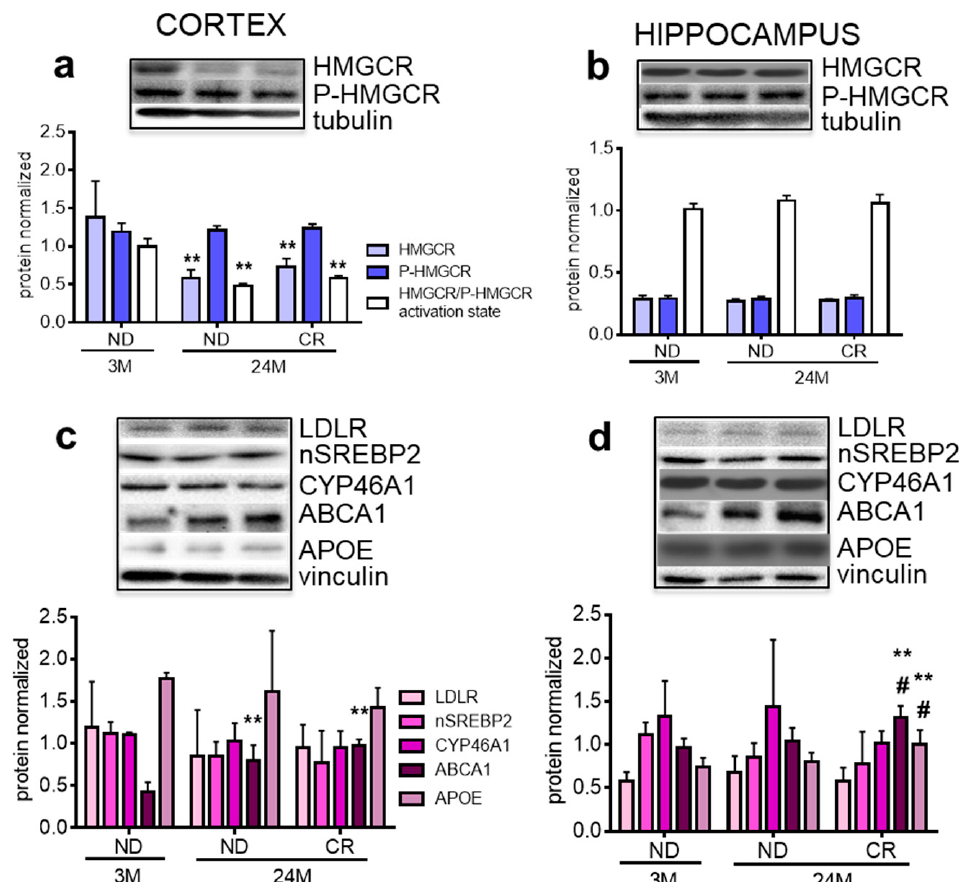
Figure 2. Impact of age and CR on proteins handling cholesterol metabolism in rat cortex and hippocampus. Panels ( a , b ) show representative Western blots and densitometric analyses of HMGCR (total and phosphorylated protein) in the cortex and hippocampus, respectively. Panel c and d show representative Western blots and densitometric analysis of other proteins involved in cholesterol homeostasis in the cortex and hippocampus, respectively. 3M (3-month-old rats); 24M (24-month-old rats); ND (normal diet); CR (caloric intake reduced by 40% for the last 6 months of life). Protein levels were normalized to tubulin ( a , b ) and to vinculin ( c , d ). Statistical analysis was performed by using one-way ANOVA followed by Tukey’s post hoc test. ** p < 0.01 vs. ND3M ND; # p < 0.05 vs. 24M ND.